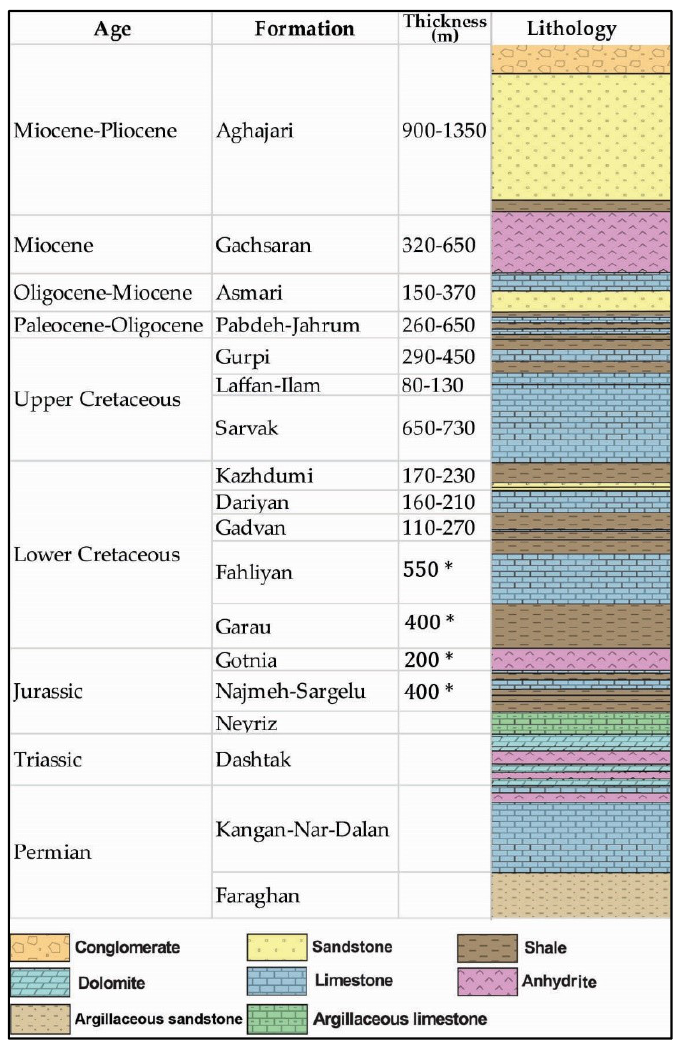
Figure 3. Stratigraphy of the Abadan Plain Basin. Observed formation thicknesses are also reported. Lithology column and Thicknesses marked by asterisk are from Reference [9].